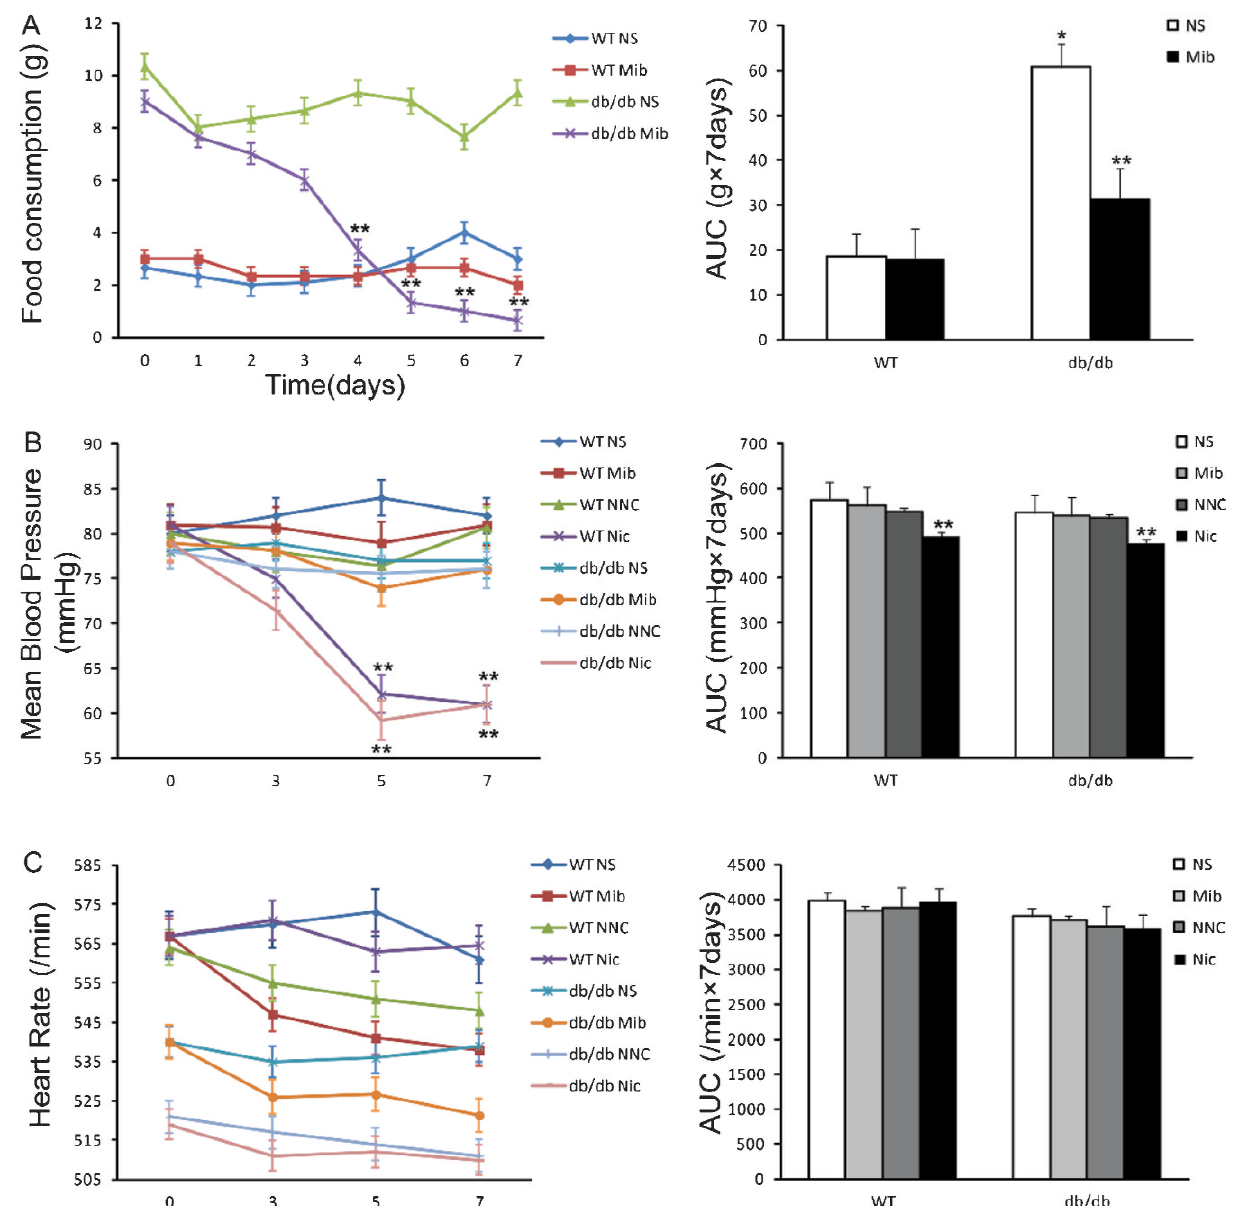
Figure 6 - Effects of mibefradil and/or nicardipine on the food consumption, mean blood pressure and heart rate of db / db and nondiabetic mice. A) Effect of mibefradil injection on the food intake of diabetic and nondiabetic mice. B) Effects of mibefradil and nicardipine on the mean blood pressure of diabetic and nondiabetic mice. C) Effects of mibefradil and nicardipine on the heart rate of diabetic and nondiabetic mice. * p , 0.05, n=6, compared with WT NS group; ** p , 0.05, n=6, compared with NS group of the same type of mice at the same time. Statistical analyses were performed with Student’s t-test (A) or ANOVA (B and C) according to the specific